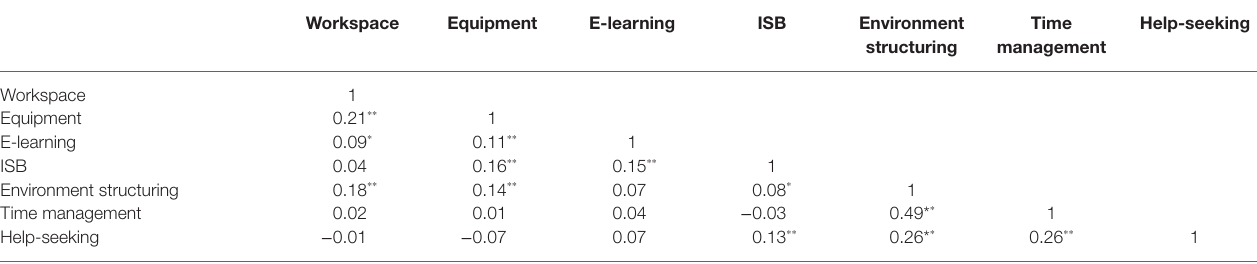
TABLE 2 | Correlations between indicators of students’ digital readiness and their use of resource management strategies during the term.